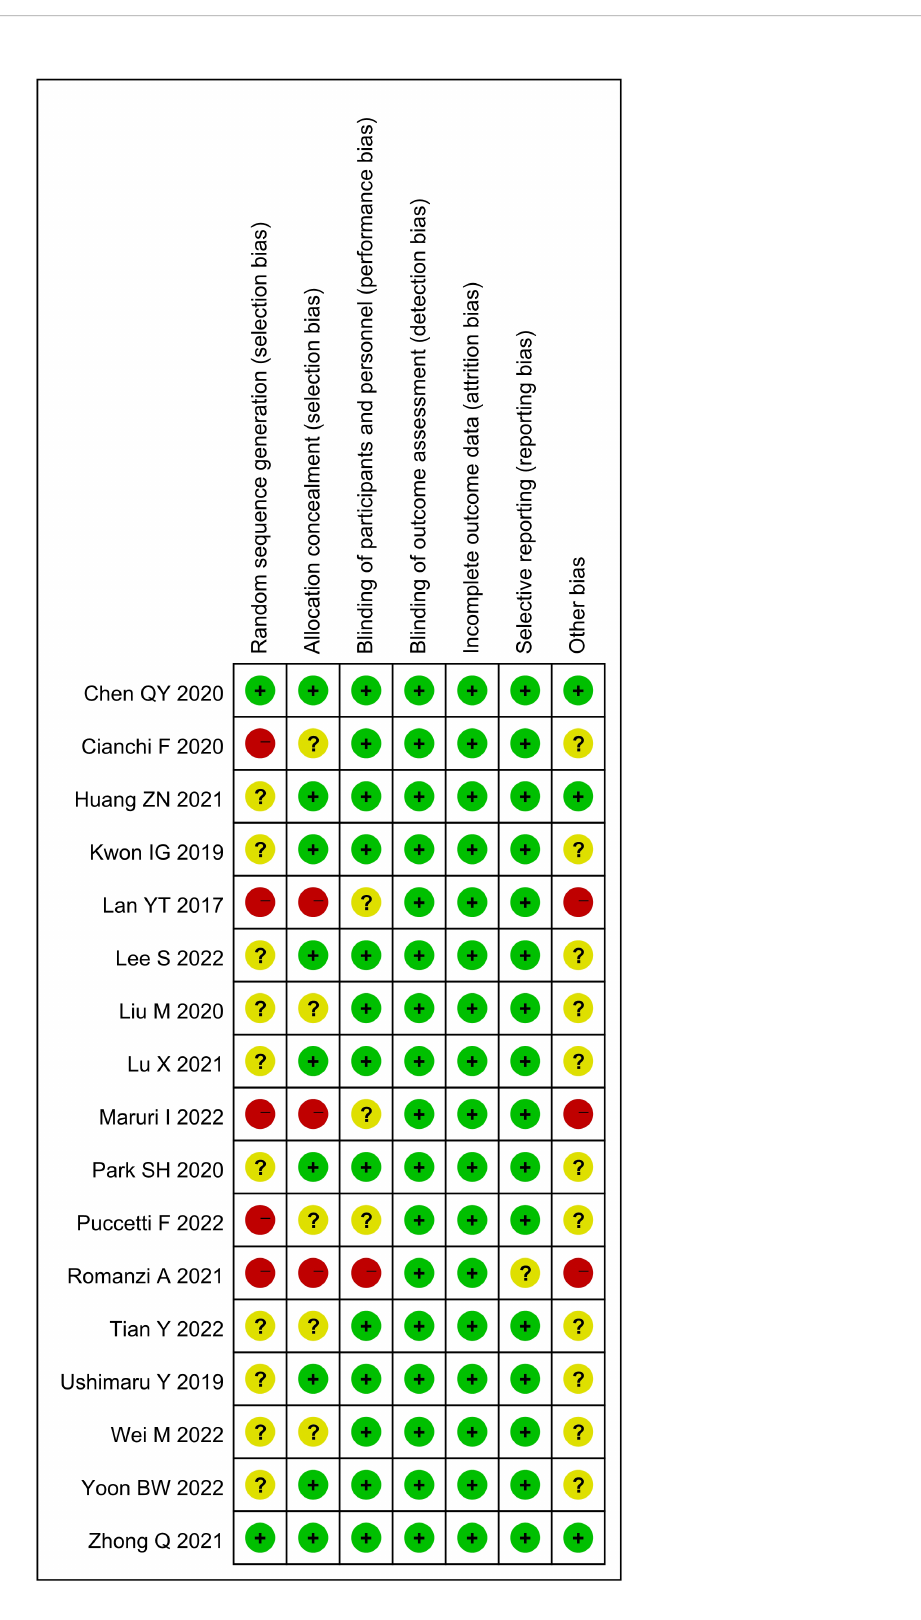
FIGURE 2 Risk of bias summary for the included